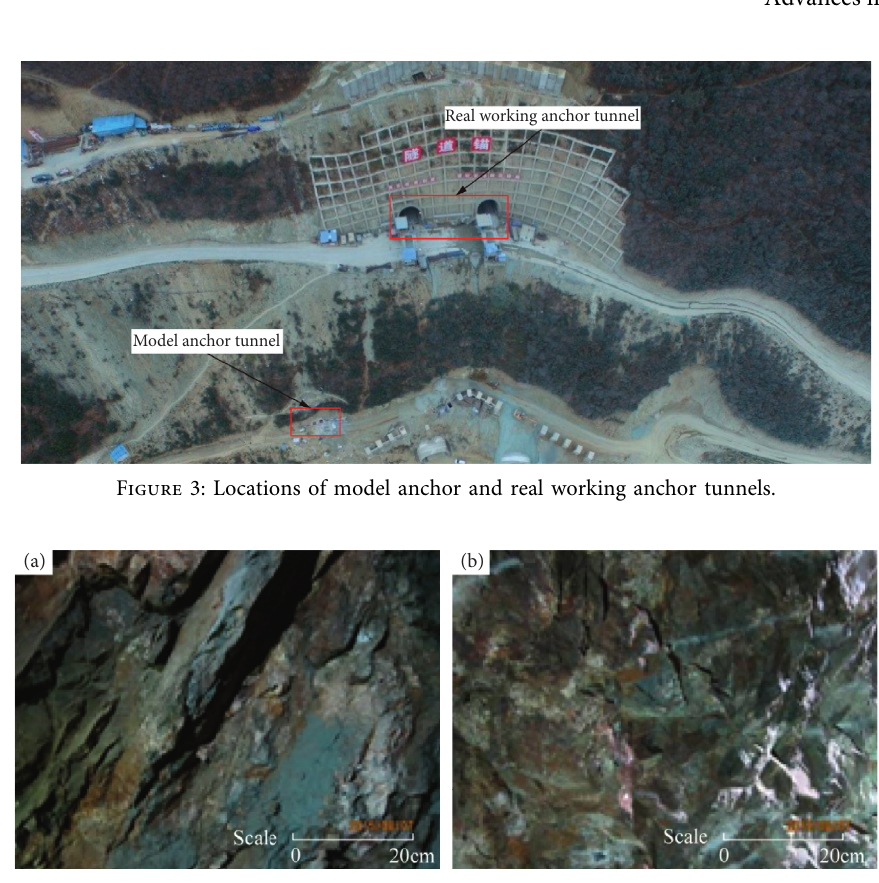
Figure 4: Surrounding rocks around (a) real working anchor tunnel and (b) model anchor tunnel. Table 1: Physical and mechanical parameters of rock